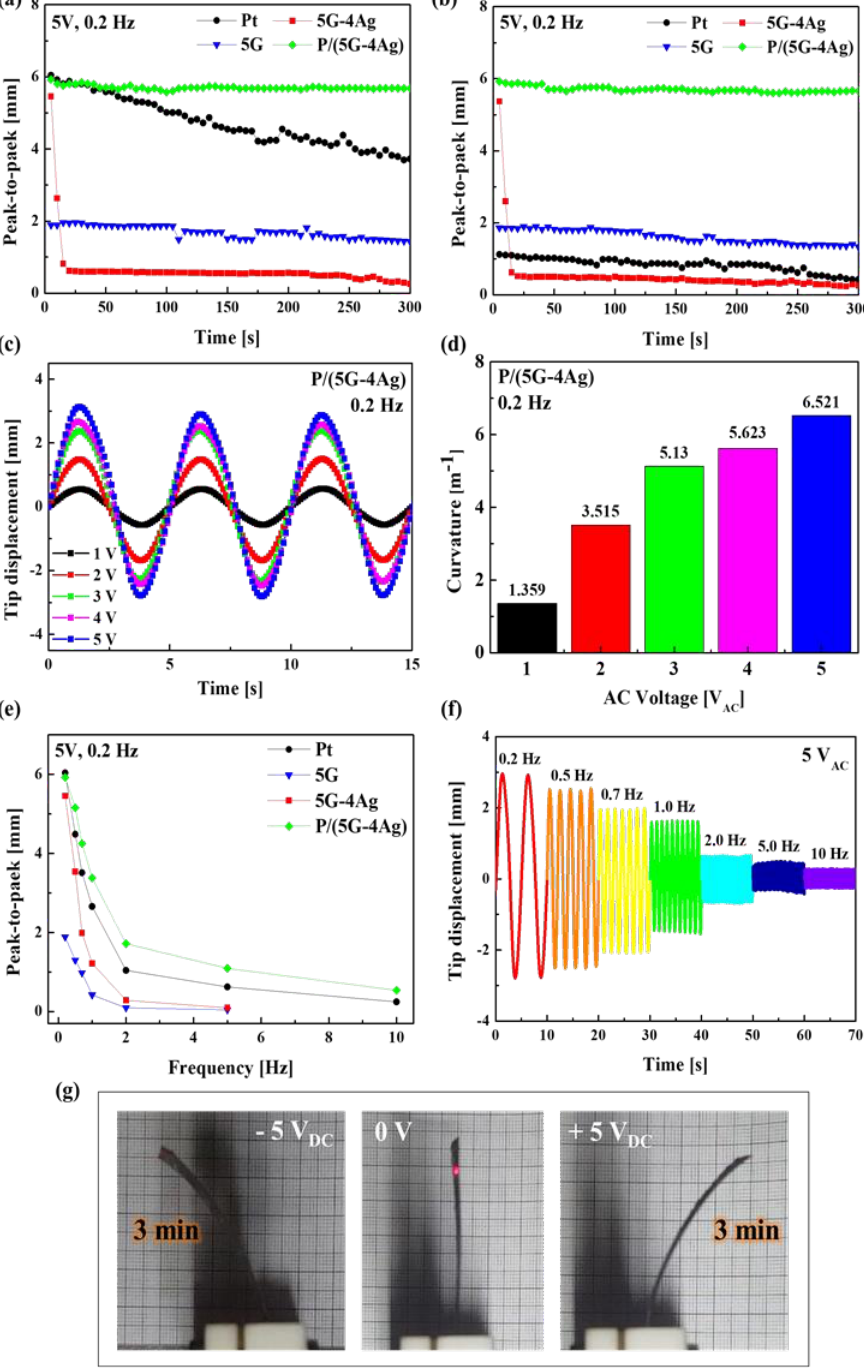
Figure 7. Open-air actuation performances of fabricated electroactive polymer actuators based on Pt, 5Gl, 5G–4Ag, P/(5G–4Ag) electrodes ( a ) before and ( b ) after drying. Bending actuation performance of the P/(5G–4Ag) actuator ( c ) under various input voltages and ( d ) their corresponding curvatures. ( e ) Bending displacement of different actuators at different frequencies. ( f ) Bending displacement of the P/(5G–4Ag) actuator at different frequencies. ( g ) The bending motion photograph of P/(5G–4Ag) actuator under the input voltage of 5 V DC